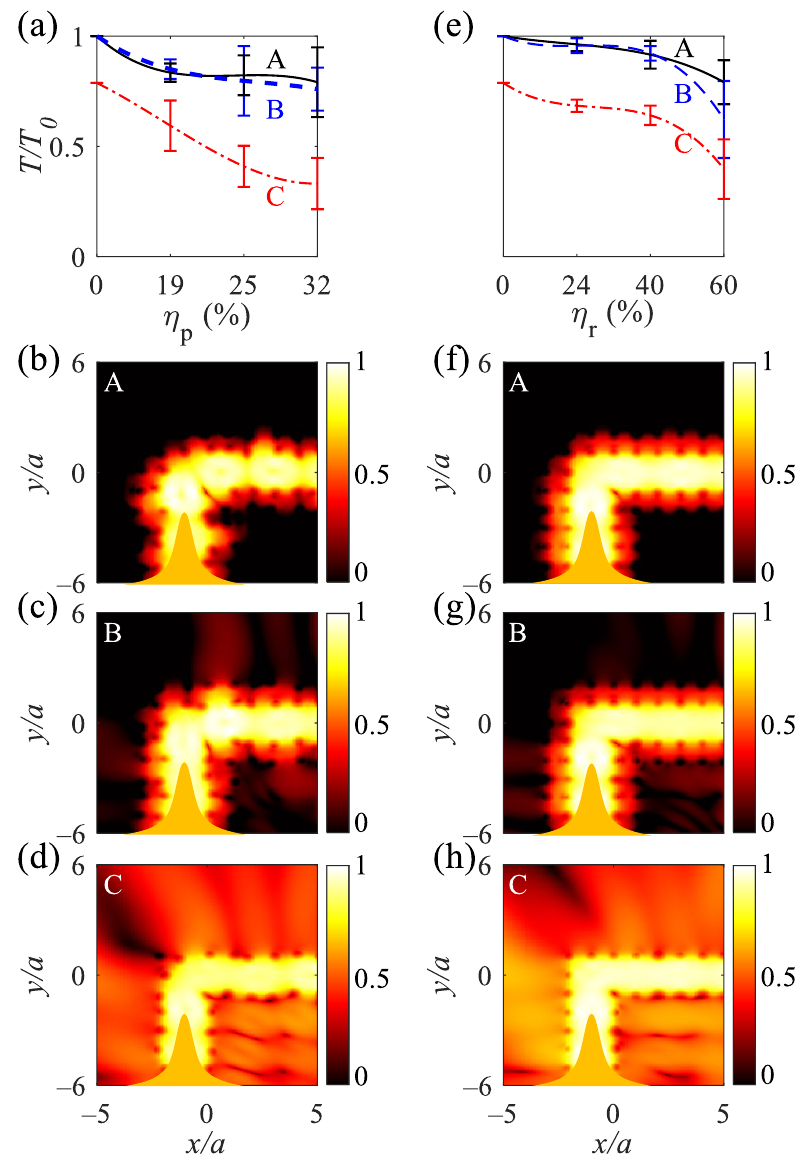
Figure 7. Normalized transmission for the A-, B-, and C-type L-shaped waveguides under the ( a ) position disordering under η p = 19, 25, and 32% and ( e ) radius disordering under η r = 24, 40, and 60%. ( b – d ) Normalized logarithmic electromagnetic power distributions at λ = 490 nm for A, B, and C-type L-shaped waveguides under η p = 19%. ( f – h ) Normalized logarithmic electromagnetic power distributions at λ = 490 nm for A, B, and C-type L-shaped waveguides under η r = 24%. The orange bell shapes at the bottom of ( b – d , f – h ) show the TM polarized Gaussian waves, propagating from − y to y , and are recorded at the right of the